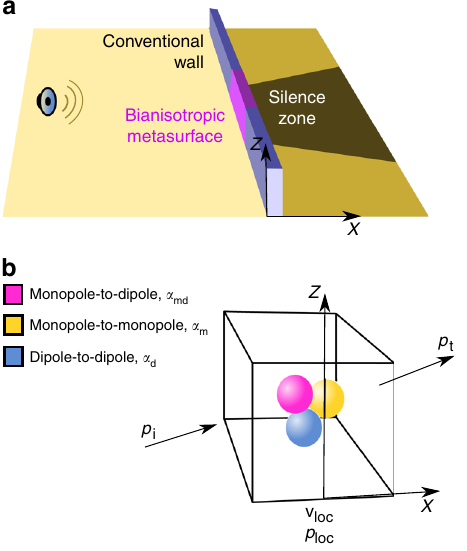
Fig. 1 Bianisotropic metasurface sound barrier. a A section of a conventional wall is replaced by a bianisotropic metasurface window designed to prevent sound from propagating behind the metasurface. b The metasurface unit cell (meta-atom) is made of three types of scattering sources (inclusions) whose acoustic responses are described in terms of bianisotropic polarizability α md and conventional polarizabilities α m and (cid:1) α The local pressure and particle velocity at the position of the inclusions are p loc and v loc